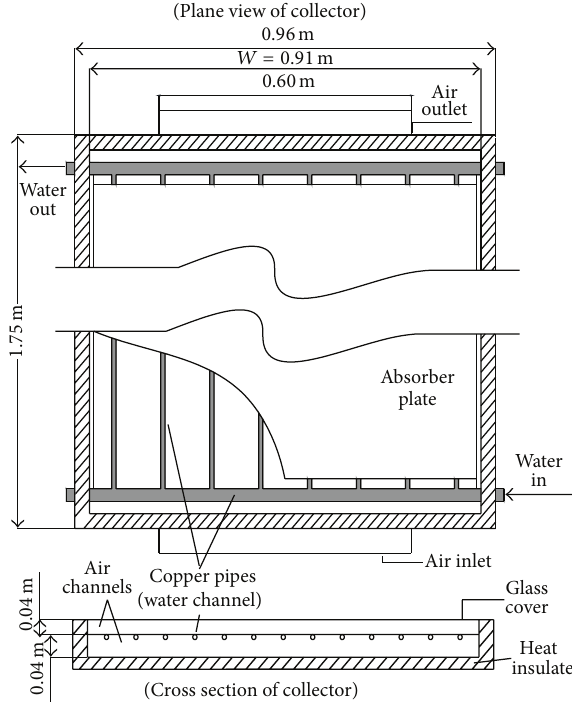
Figure 1: Schematic diagram of the dual-function solar